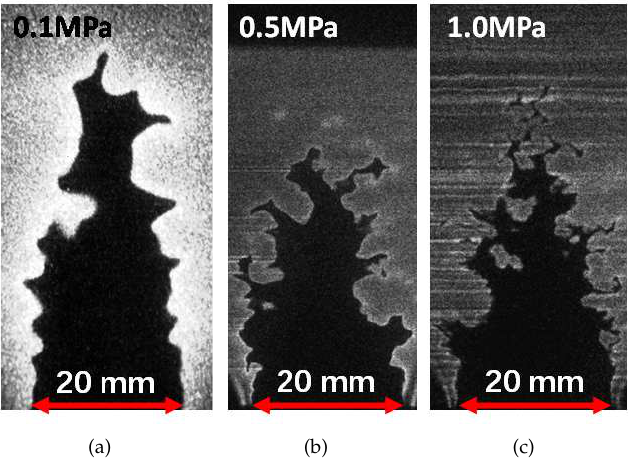
Figure 4. Typical OH-PLIF images at U = 3.0 m/s: ( a ) 0.1 MPa; ( b ) 0.5 MPa; ( c ) 1.0 MPa.